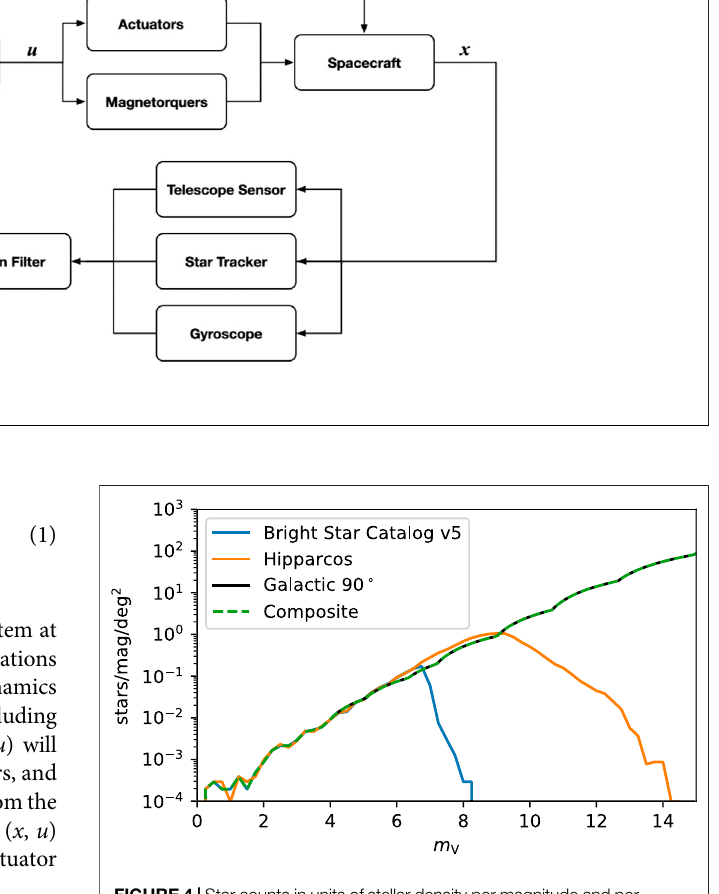
FIGURE 4 | Star counts in units of stellar density per magnitude and per squaredegree.Thedashedcurverepresentsthedensityusedinthisworkand represents a composite of the Bright Star catalog (Hof fl eit D., 1991) for bright stars, and the galactic pole curve from the study by Bahcall and Soneira (1980) at dimmer magnitudes provides a lower limit on stellar density by assuming the observations are of the sparsest region of the sky. This composite represents a conservative estimate of the number of photons available to localize spacecraft attitude